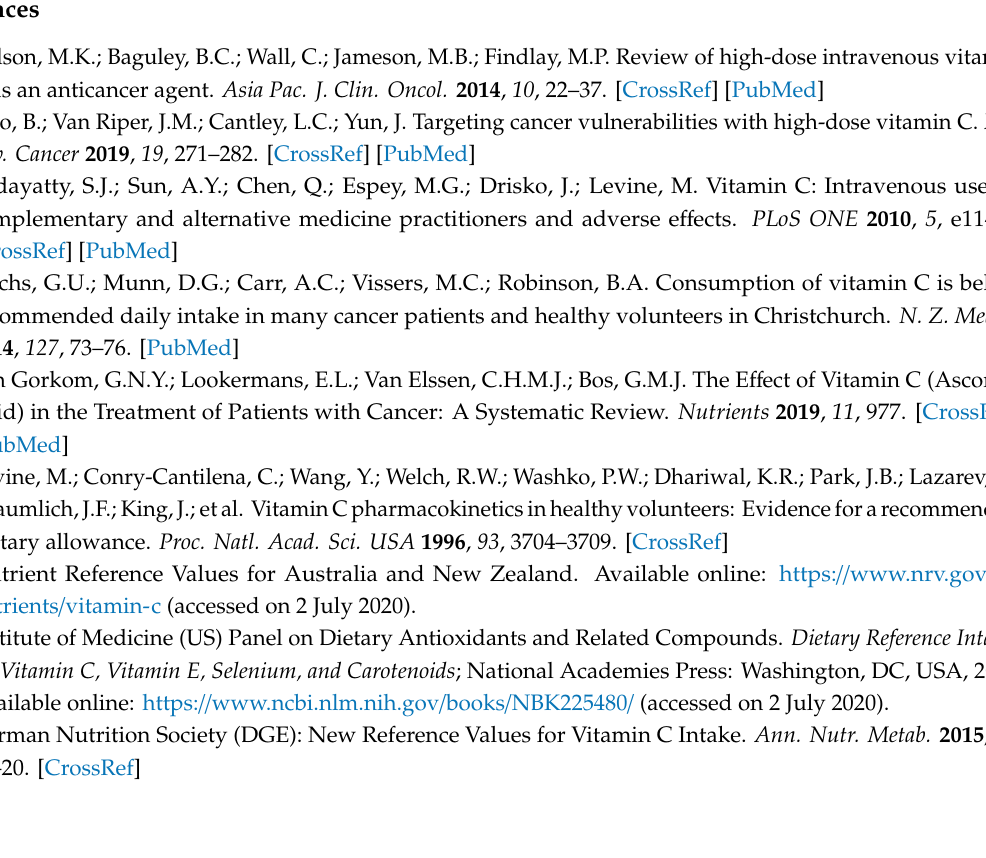
Table S1: Characteristics of the two cohorts of patients with